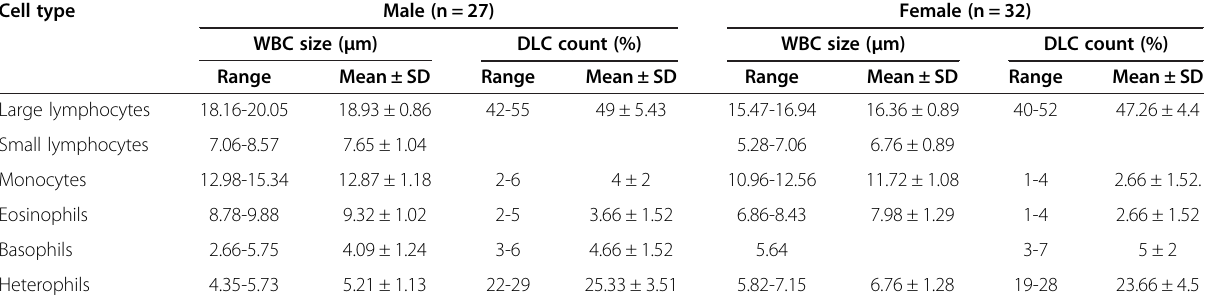
Table 2 Sizes of white blood cells (WBCs) and differential leukocyte counts (DLCs) in male (n = 27) and female (n = 32) Naja naja snakes (p <